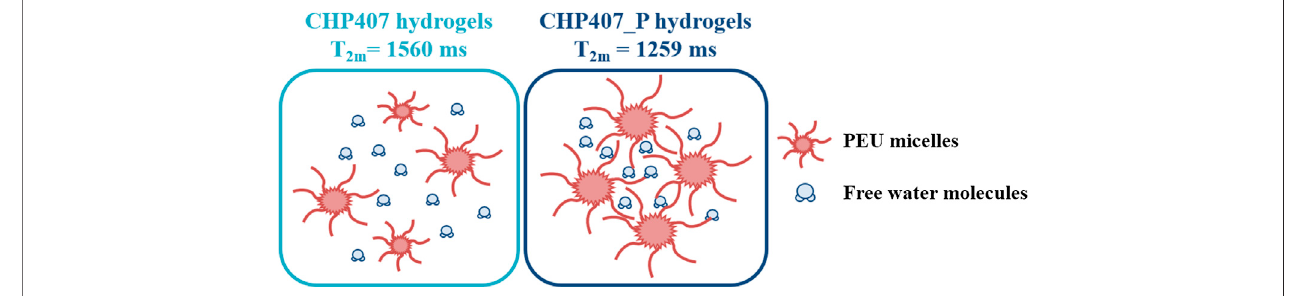
FIGURE 9 | Schematic representation of CHP407 and CHP407_P hydrogel internal structure at 37 ° C inspired by LF-NMR data.